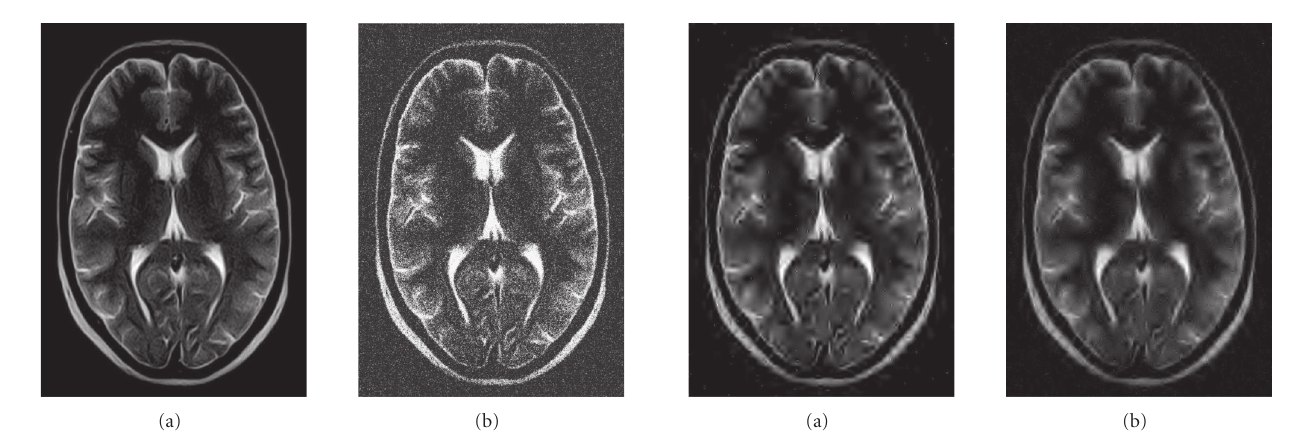
Figure 2: (a) Denoised image by wavelet hard thresholding PSNR = 8 . 65(dB), with the selected threshold that returns the best PSNR performance. (b) Denoised image by wavelet soft thresholding PSNR = 8 . 36(dB); the threshold is selected to reach the best PSNR improvement. We note that the hard thresholding gives better PSNR performance because it is optimal in the L 2 norm sense, but the soft thresholding gives better visual quality because its Gibbs’ oscilla- tions are less severe.